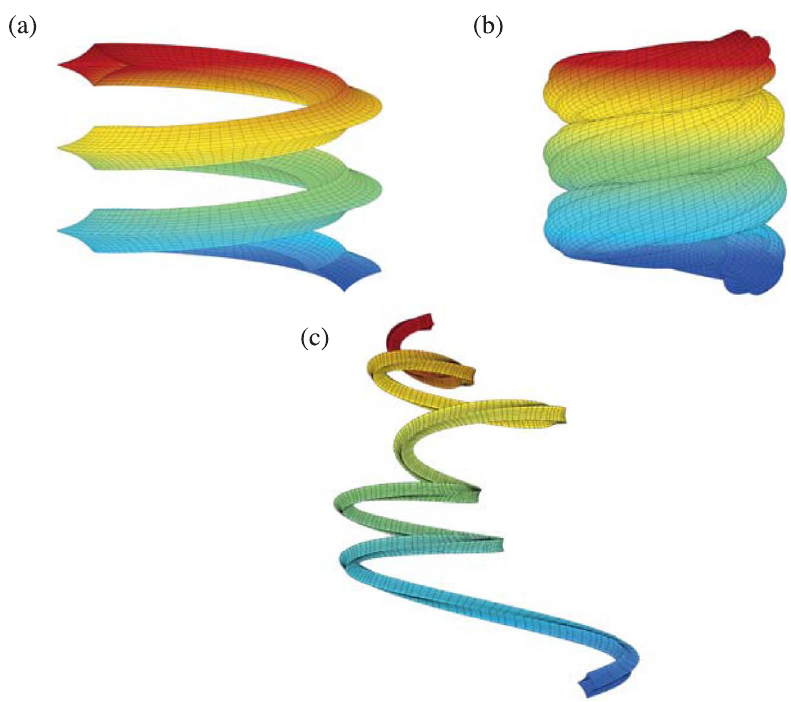
Figure 2. Examples of the GTR bodies which have different basic lines, radial cross-sections and numbers of